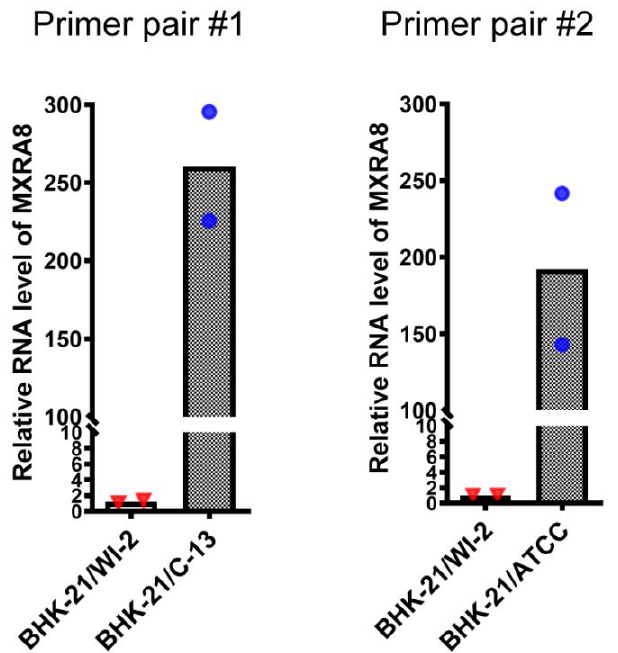
Figure 4. Quantitation of MXRA8 RNA in BHK-21/WI-2 and BHK-21/C-13 cells. Total RNA in BHK-21/WI-2 and BHK-21/C-13 cells was extracted and reverse-transcribed. The level of hamster MXRA8 RNA was measured by qPCR using two different primer pairs as described in the methods. Data shown are the mean and individual data points of 2 independent experiments, with the level of MXRA8 RNA in the BHK-21/WI-2 cells set to 1.